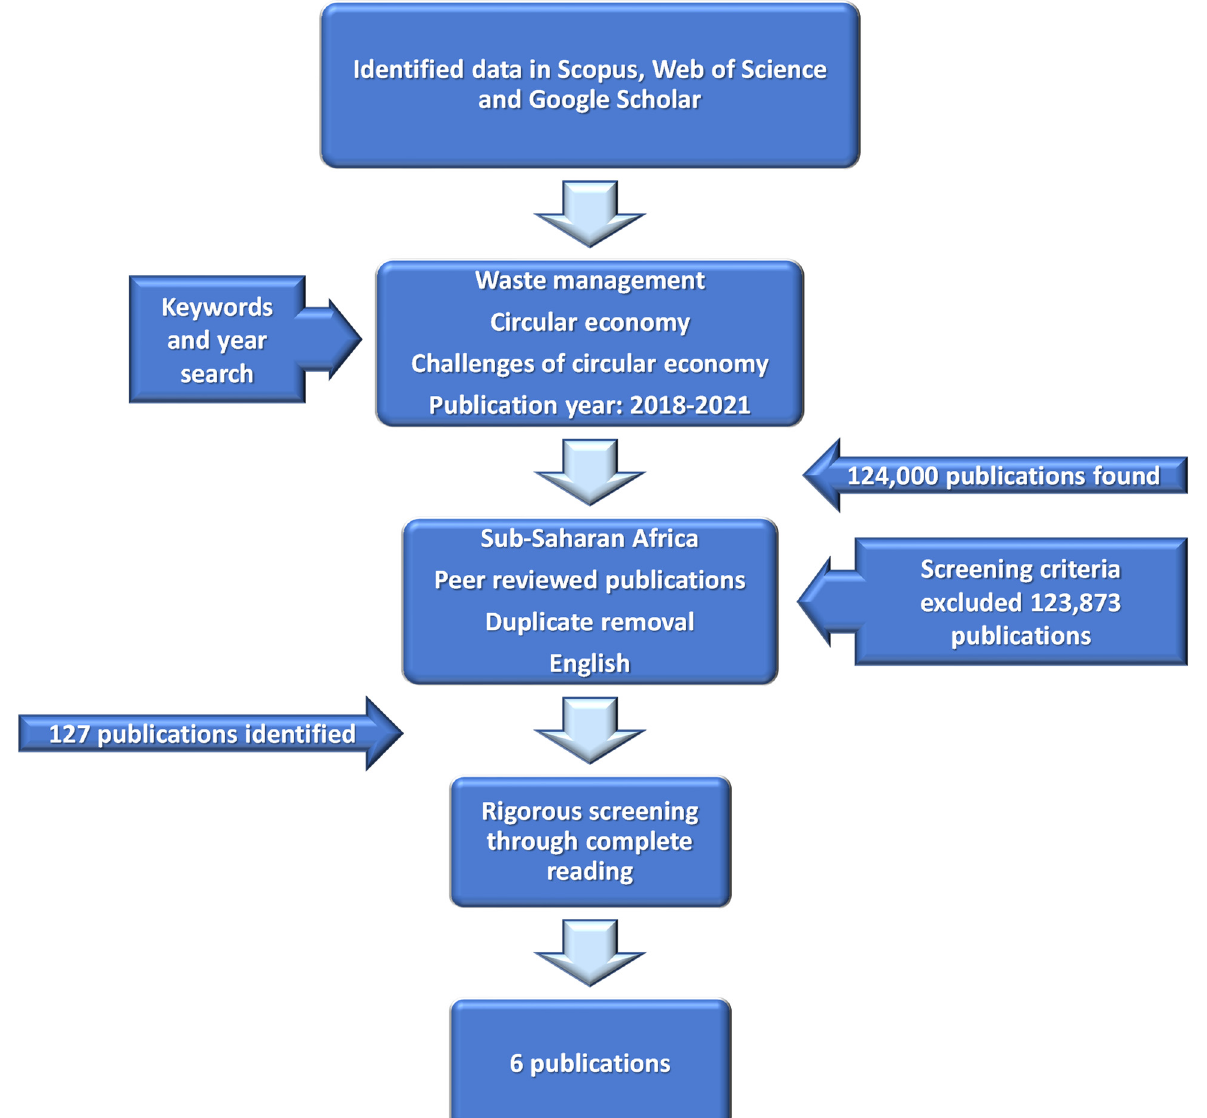
Figure 5. Scheme for the review indicating database and screened retrieved manuscripts, adapted from Panigrahi and Dubey [58] and Yu et al. [59].